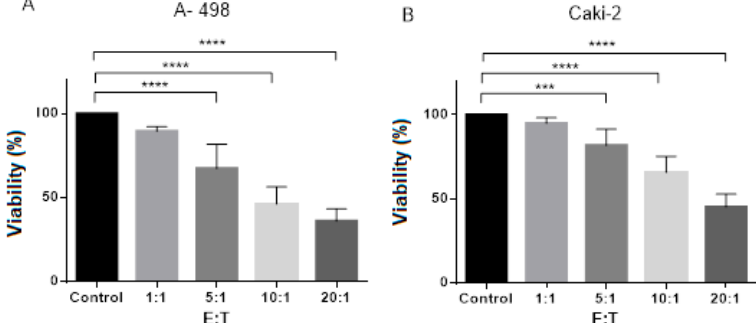
Figure 3. Effects of different CIK cells numbers on the viability of renal cells (effector:target (E:T) ratio) after 72 h of coculture. n = 3 healthy donors. ( A ) Coculture of CIK cells and A-498 in different ratios. ( B ) Coculture of CIK cells and Caki-2 in different ratios. Absorbance values have been normalized into percentages with each untreated control showing 100% viability as a reference. *** represents a p value < 0.001, **** represents comparing to untreated tumor cells control, a p value < 0.0001. E:T ratio represents a ratio of effector cells (CIK cells) and target cells (tumor cells).